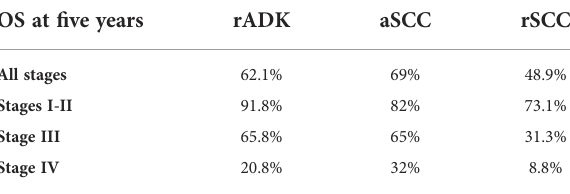
TABLE 2 Comparison of fi ve-year survival by stage for rectal squamous cell carcinoma, anal squamous cell carcinoma and rectal adenocarcinoma based on data from the Astaras study